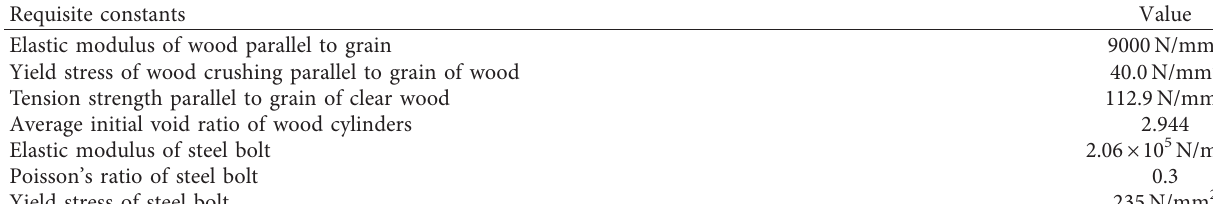
Figure 3: Compression curves of confined compressed wood cylinders parallel to the grain: (a) equivalent stress versus change of void ratio; (b) the logarithmic bulk modulus versus change of void ratio. Table 3: The material properties for FE modeling.